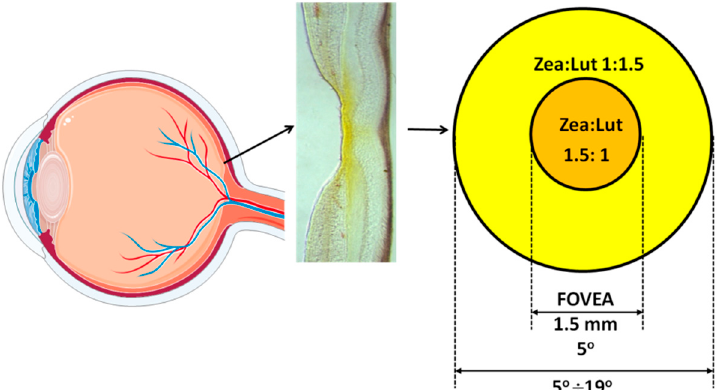
Figure 4. Vertical section of a monkey fovea showing the distribution of macular xanthophylls (yellow color). (Adapted with permission from Snodderly, D.M., 1995. Am J. Clin. Nutr. 62, 1448S-1461S [23].) The zeaxanthin-to lutein ratio at 0–5° is 1.5:1.0; at 5–19°, 1.0:1.5; and at 19–38°, 1.0:2.0 (a 1° angular subtense in the retina represents 0.29 mm of retinal extent) [7,39].